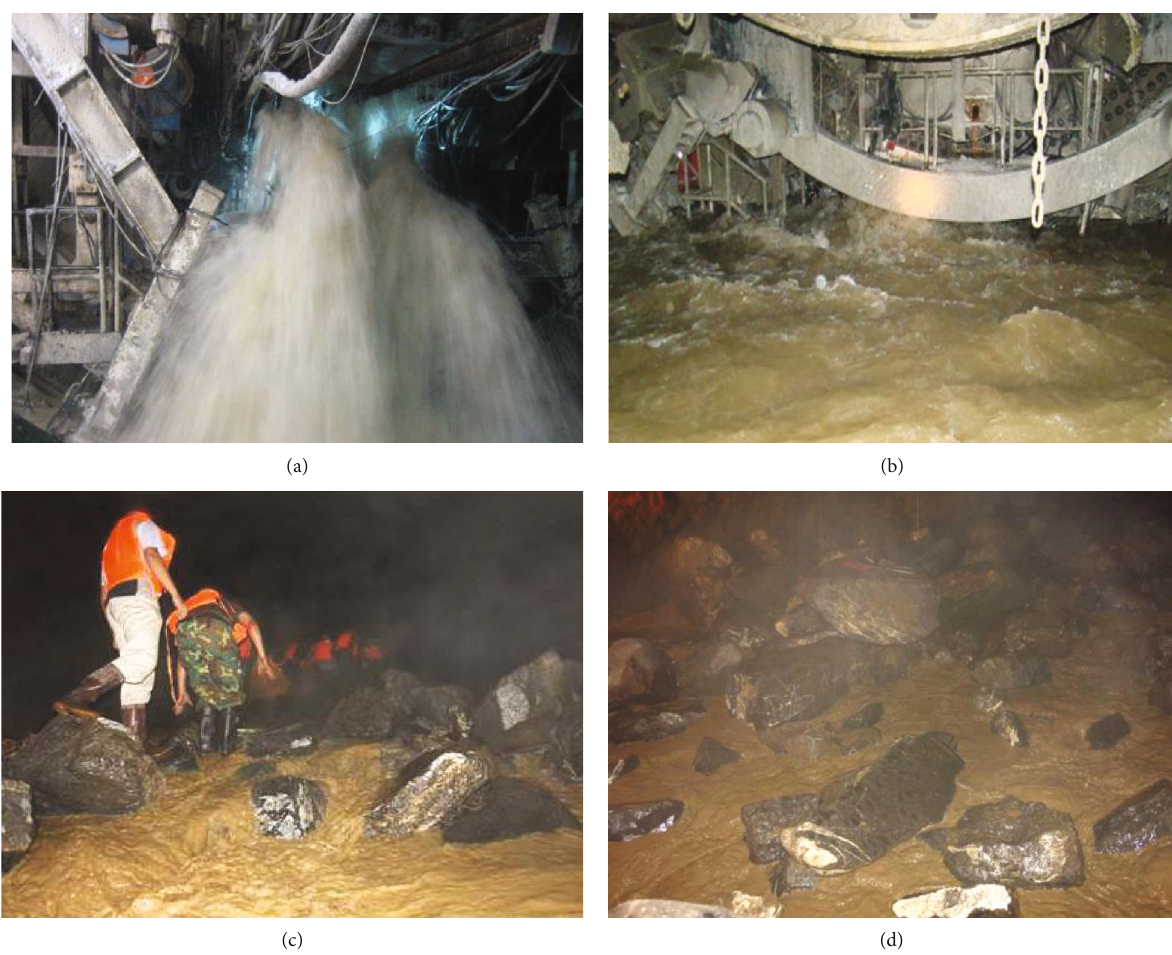
Figure 1: Typical geological disasters of water burst in underground engineering.